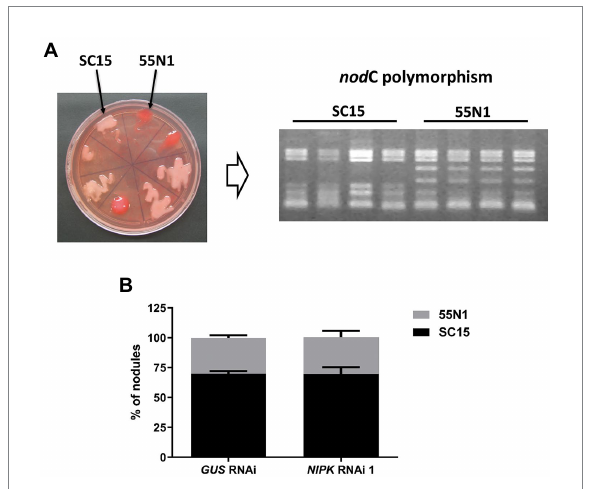
FIGURE 8 NIPK RNAi does not affect strain preference. (A) Representative plate showing the nod C- α strain SC15 (pale pink) and the nod C- δ strain 55 N1 (red) of Rhizobium etli growing in Congo red media. Identity of nodule occupying strains was confirmed by ARFLP analysis of the nodC polymorphism. (B) Percentage of nodule occupancy by each strain in GUS and NIPK RNAi 1. Error bars represent SEM of two independent